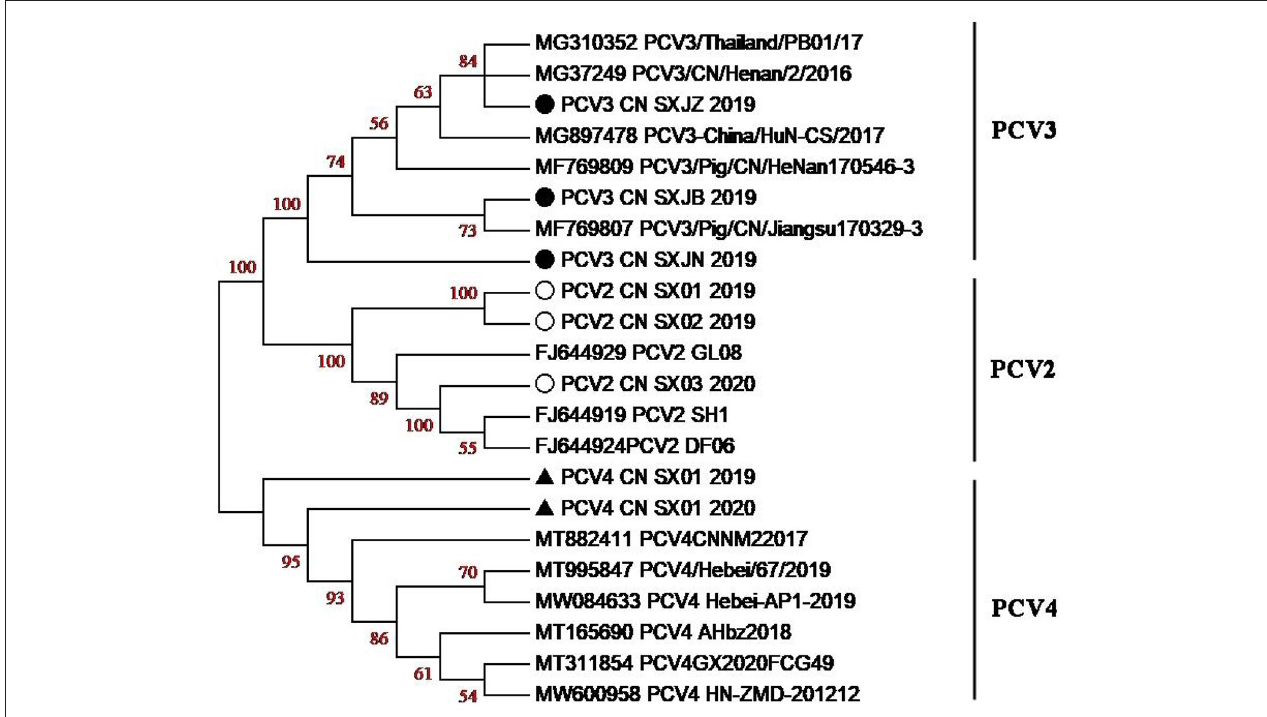
FIGURE 4 | Phylogenetic tree based on the ORF2-encoding gene of PCV2, PCV3, and PCV4 strains. The PCV strains clustered into three subgroups, namely, PCV2, PCV3, and PCV4. Black solid circles (•) indicate PCV3 strains, hollow circle ( ◦ ) indicates PCV2 strains, black solid triangle ( N ) indicates PCV4 strains in this study,